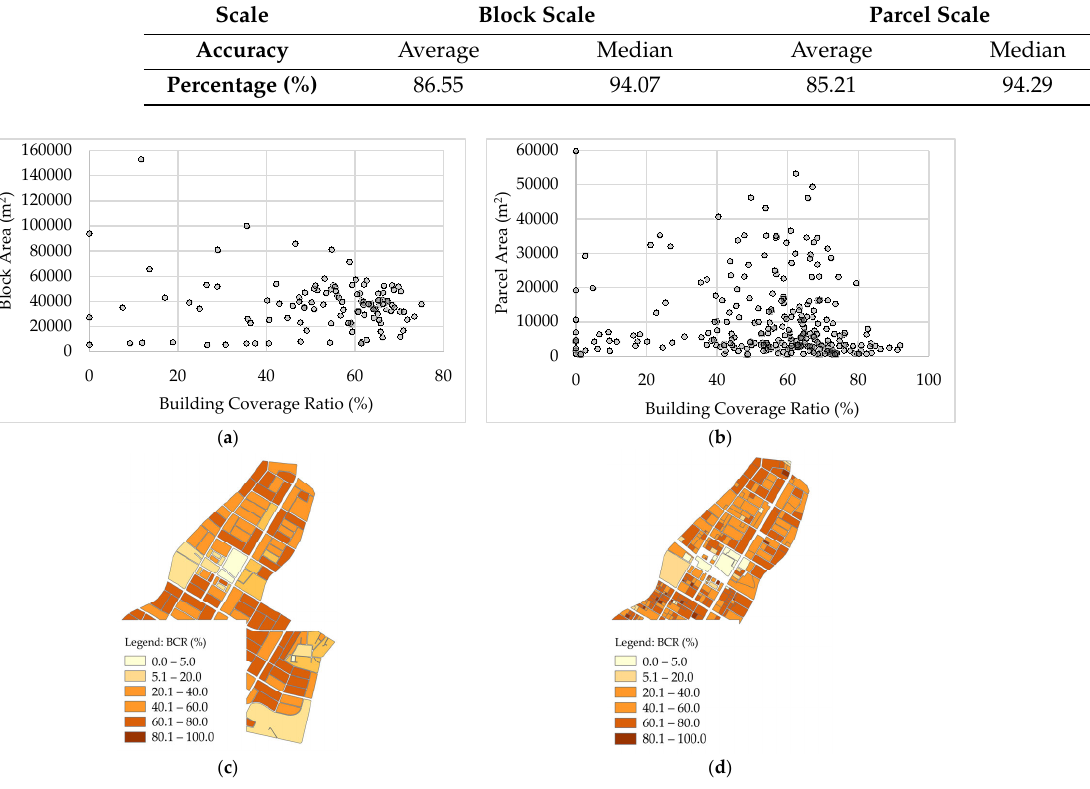
Figure 7. BCR distribution ( a ) at the block scale, and ( b ) at the parcel scale. Thematic map visualizing the BCR ( c ) at the block scale, and ( d ) at the parcel scale.